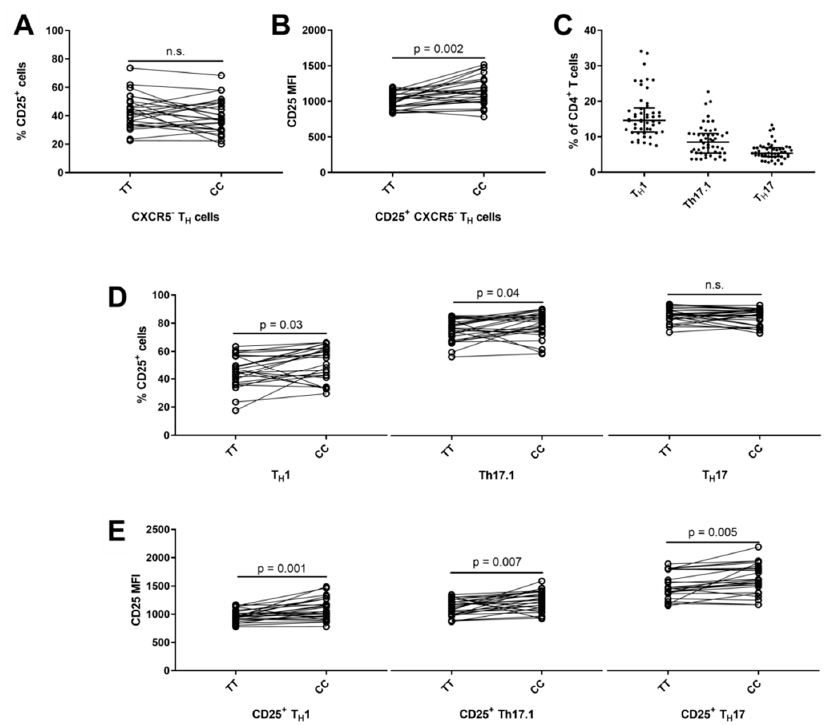
Figure 5. IL2RA genotype associations on CD4 + non ‐ follicular T helper subsets. Non ‐ follicular T